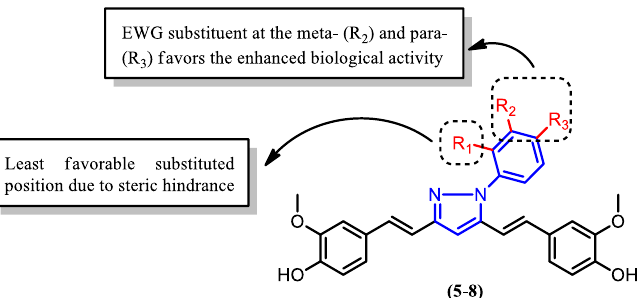
Figure 12. Pyrazole derivatives of curcumin with a phenyl group attached to the nitrogen atom. The presence of different groups, either electron donating (EDG) or electron withdrawing (EWG), on the phenyl group varyingly influences the bioactivity of the compounds.